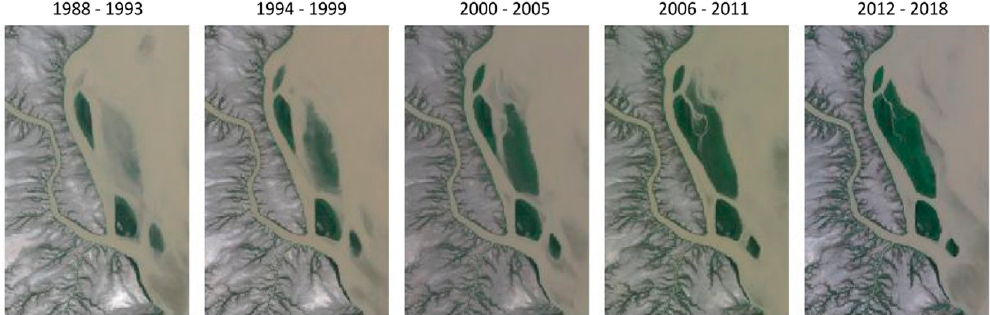
Figure 6. Consistent time step composites at a mid-tide range, Keep River West, NT: using observations drawn the middle 20th percentile (i.e., 40 to 60th percentile) of the observed tidal range,